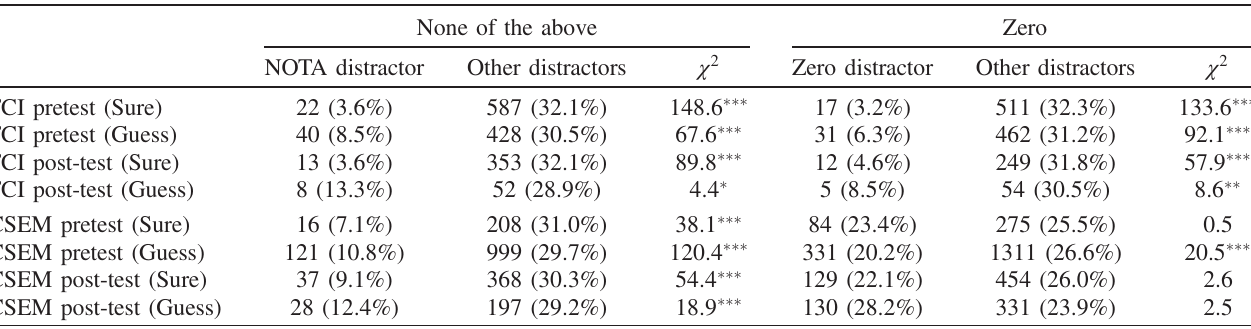
TABLE IV. Distractor distribution for students who are “ sure ” of their answer and students who are “ guessing ” in data set 1. Total number and percentage of students selecting the testwiseness-affected distractors and other distractors in questions which have a NOTA distractor or zero distractors. For category other distractors the number is the total number of selections for all three other distractors and the percentage is the average percentage for one of the three. Superscripts * denotes p < 0 . 05 , ** denotes p < 0 . 01 , and *** denotes p < 0 . 001 based on a χ 2 test of difference from a random